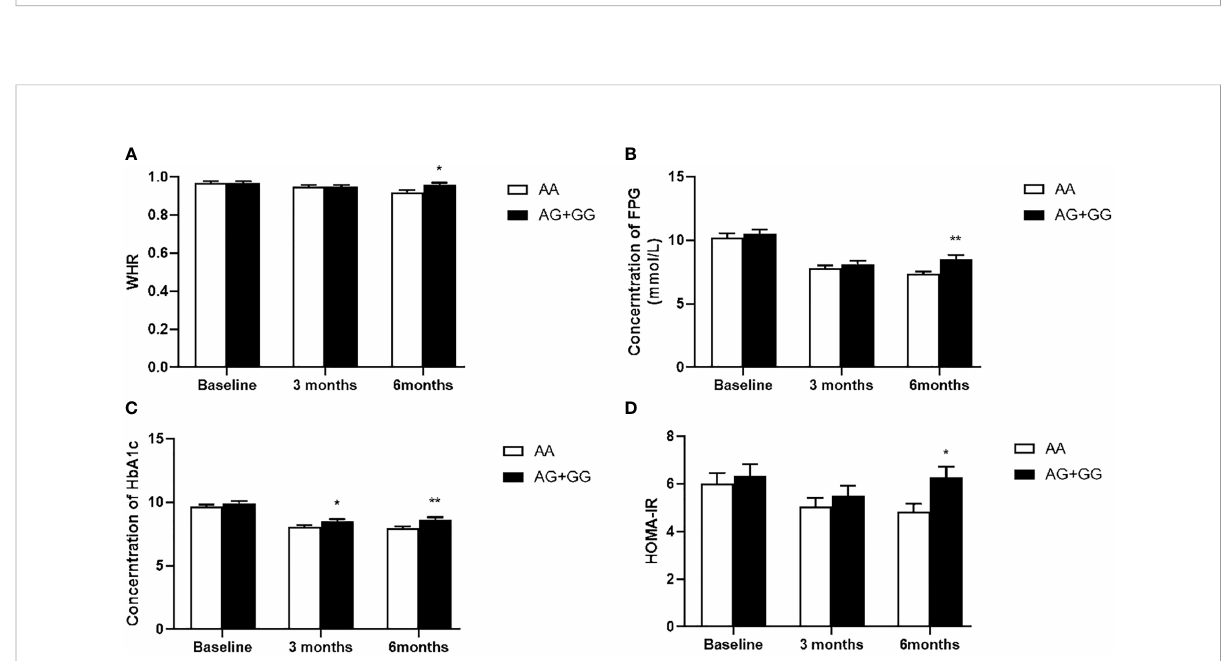
FIGURE 2 Comparison of waist to hip ratio (WHR) (A) , fasting plasma glucose (FPG) (B) , hemoglobin A1c (HbA1c) (C) and homeostasis model assessment for insulin resistance (HOMA-IR) (D) between T2DM patients with the AA genotype (n = 50) and those with AG and GG genotypes (n = 55) genotypes of PPARD rs3777744 in T2DM patients before, at 3 months and at 6 months of exenatide treatment. Data are expressed as the mean ± SE, * P <0.05 and ** P <0.01 compared with AA genotype group (n = 105).